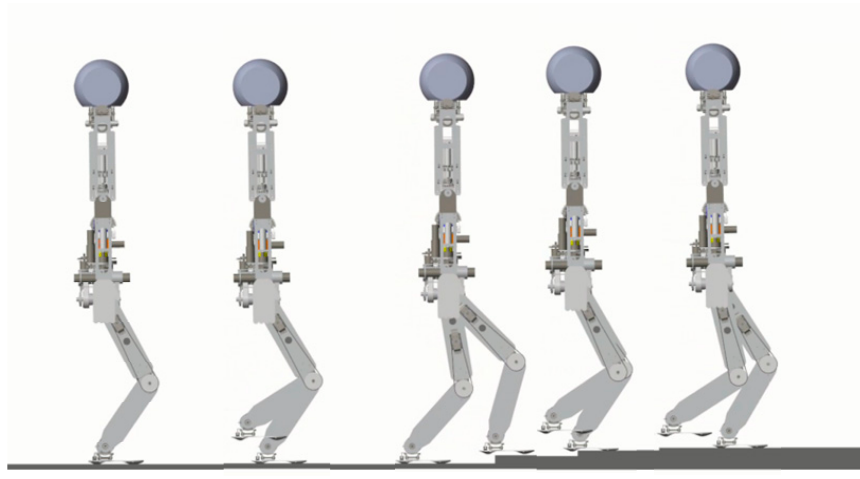
Figure 20. Snapshots of the second simulation: the biped walks on uneven ground.